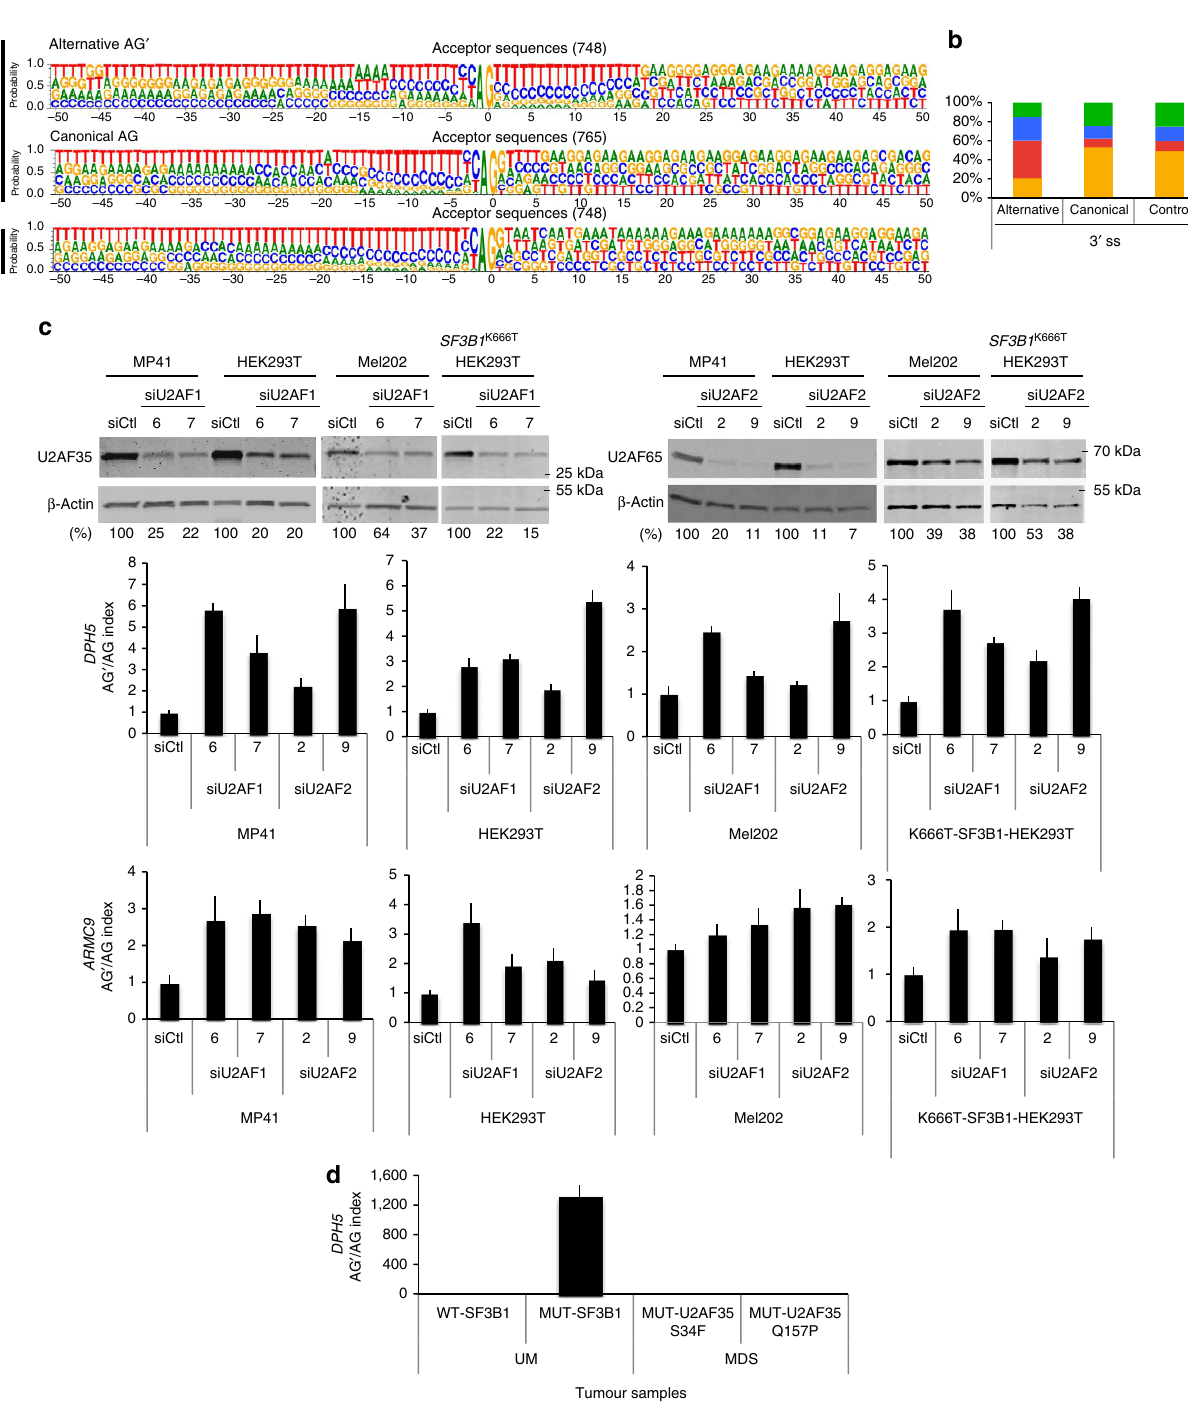
Figure 4 | Characterization of alternative 3 0 ss (AG’) sequences. ( a ) Comparison of sequence logos of 3 0 ss sensitive to SF3B1 status with canonical (AG) and alternative (AG’) sequences and 3 0 ss insensitive to SF3B1 status. One-hundred-nucleotide-long sequences surrounding the 3 0 ss were used to generate sequence logos with WebLogo. The height of each letter indicates the preference strength for that nucleotide at each position. ( b ) The proportion of the nucleotides immediately following the alternative (AG’), the canonical (AG) and insensitive 3 0 ss. ( c ) Effect of U2AF35 and U2AF65 siRNA-mediated knockdown on the AG’/AG ratio in cell lines. MP41 and HEK293T ( SF3B1 WT ) and Mel202 and SF3B1 K666T -HEK293T ( SF3B1 MUT ) cells were transiently transfected with non-target control siRNA, si U2AF35 or si U2AF65 . Proteins and RNA were extracted at 48h after transfection. siRNA-mediated knockdown was confirmed by immunoblotting with anti-U2AF35 and anti-U2AF65, using anti- b - actin as a loading control. Numbers represent the protein band intensity normalized to b - actin and expressed as percentage of control samples (upper panel). Ratio of expression levels of alternative AG’ form to the expression level of canonical AG form (AG’/AG) of DPH5 and ARMC9 was determined by quantitative RT–PCR (lower panel). The results are average of three replicates and are represented as mean ± s.d. ( d ) Effect of U2AF35 hotspot mutations on the AG’/AG ratio of DPH5 in MDS tumours. Ratio of expression levels of alternative AG’ form to the expression level of canonical AG form (AG 0 /AG) of DPH5 was determined by quantitative RT–PCR in two MDS samples, each harbouring one of the two U2AF35 hotspot mutations, S34F and Q157P and compared with mutated and wild-type SF3B1 uveal melanoma (UM)